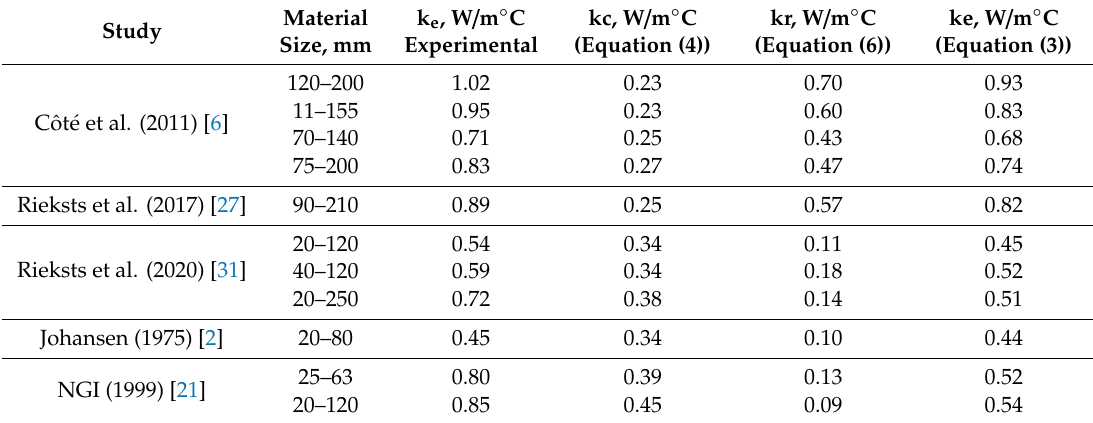
Table 8. Experimental and theoretical values of e ff ective conductivity from di ff erent